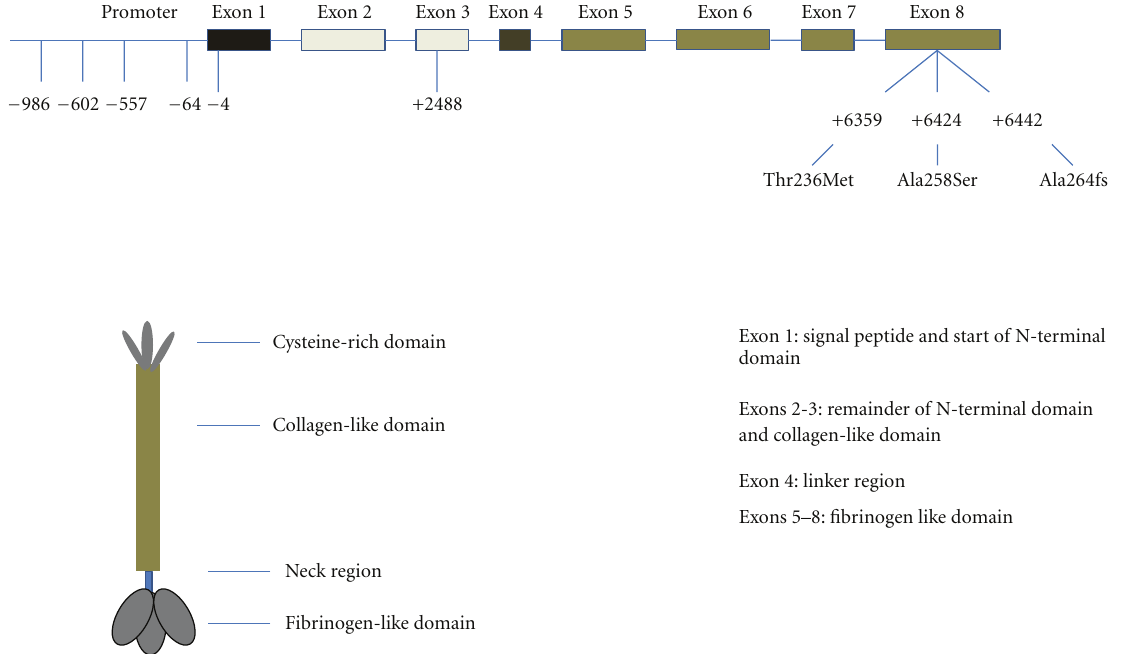
Figure 1: The human FCN2 gene. The positions of the major single nucleotide polymorphisms are shown. The mutation at +6442 leads to a deletion (fs = frameshift mutation).